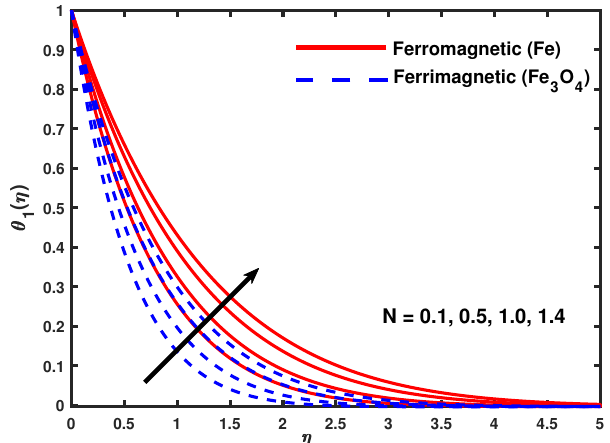
Figure 12. Impact of magnetic nano-particles and thermal radiation ( N ) on the temperature profile θ 1 ( η ) .